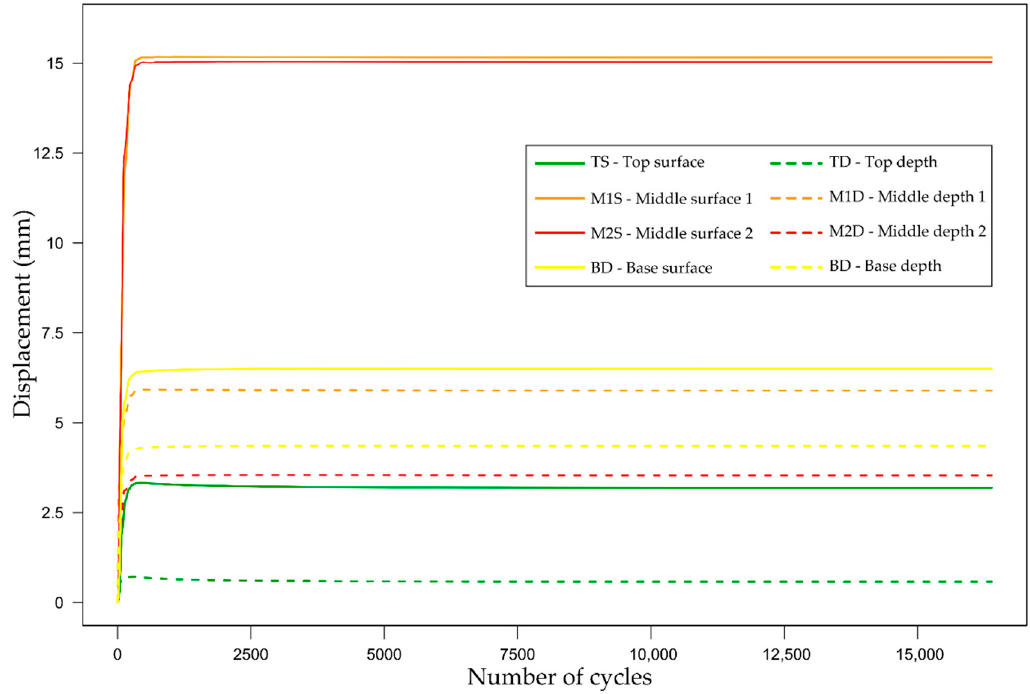
Figure 11. History points of displacement magnitude (for the location of the points, see Figure 3). (high-resolution image available at https://doi.org/10.6084/m9.figshare.14920125.v2).